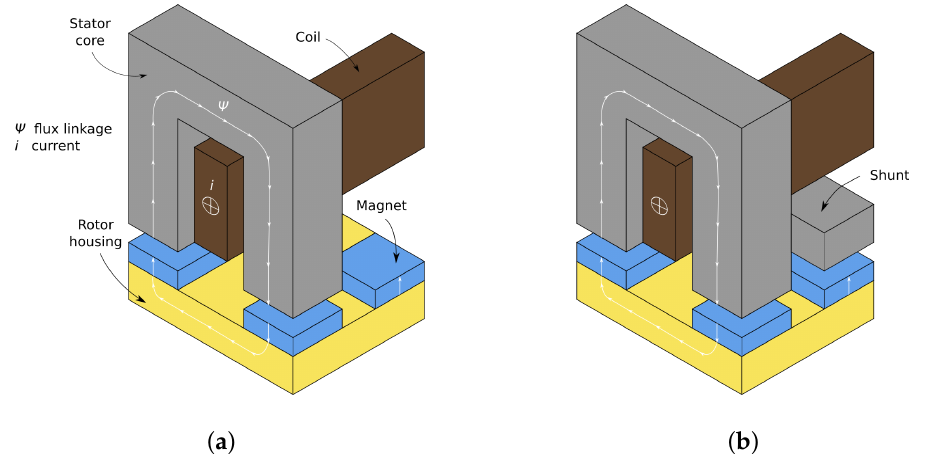
Figure 2. One pole pair of a basic TFM: ( a ) without shunts, ( b ) with shunts.